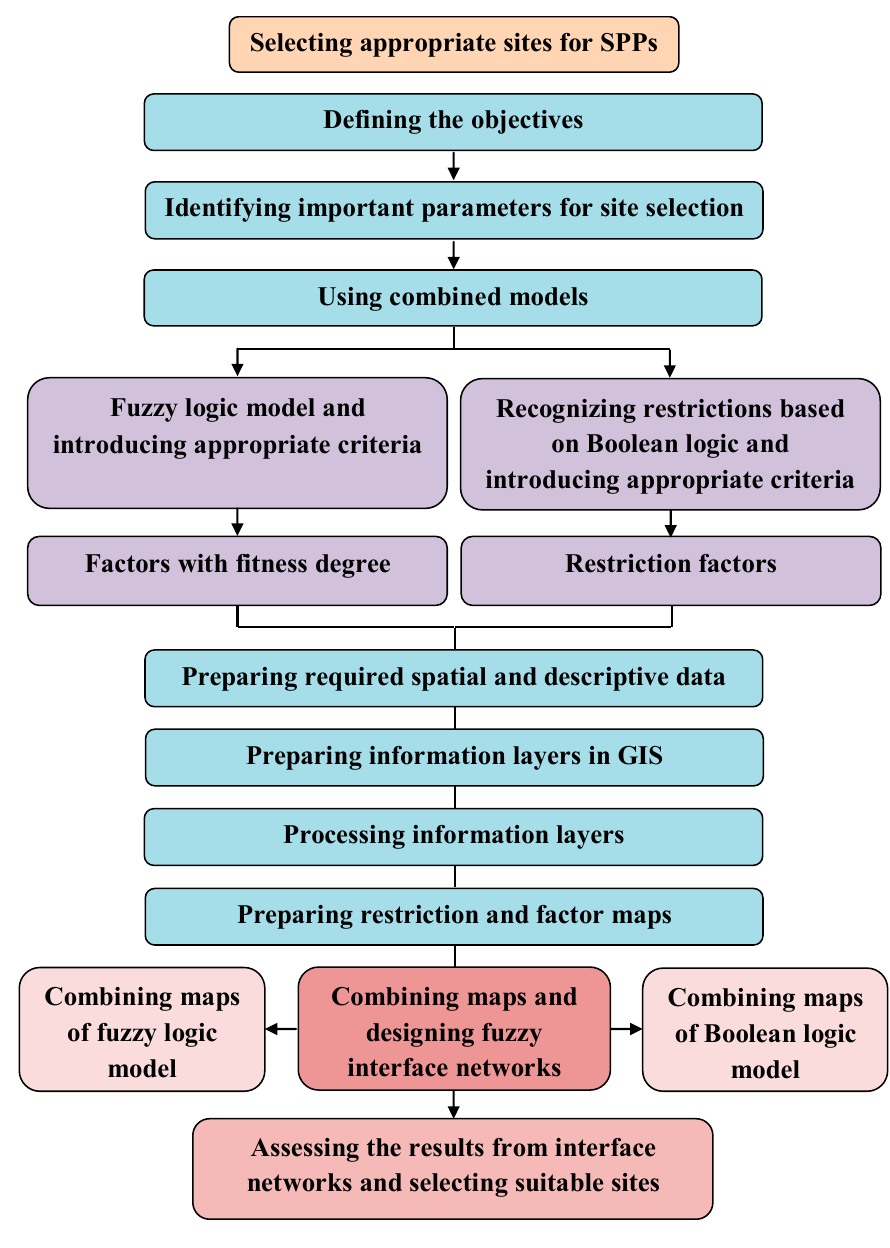
Figure 3. Conceptual framework of the research.